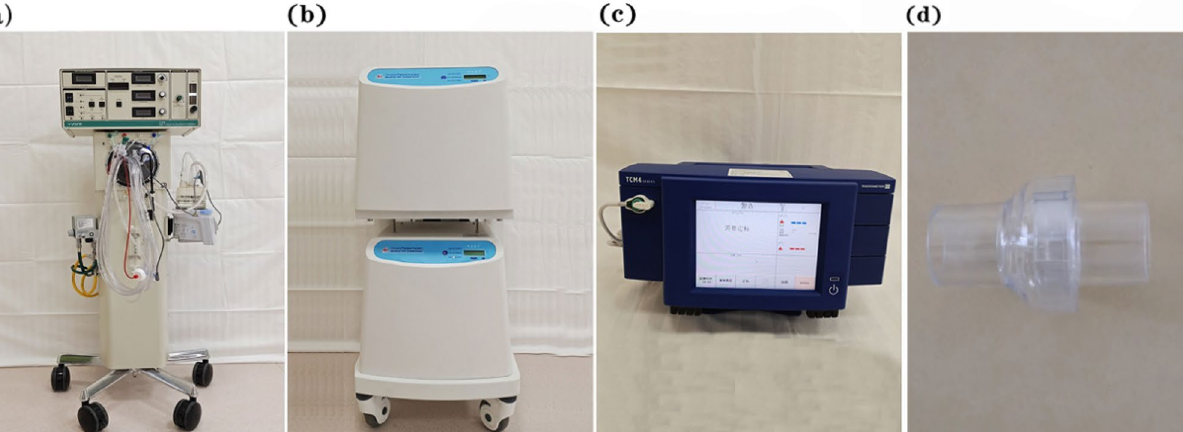
Figure 1. Non-invasive high-frequency oscillatory ventilator (NIHFOV) and its auxillaries. ( a ) High-frequency oscillatory ventilator; ( b ) Medical air compressor; ( c ) Percutaneous partial pressure of oxygen/carbon dioxide monitor; ( d ) leakage valve of non-invasive the ventilator